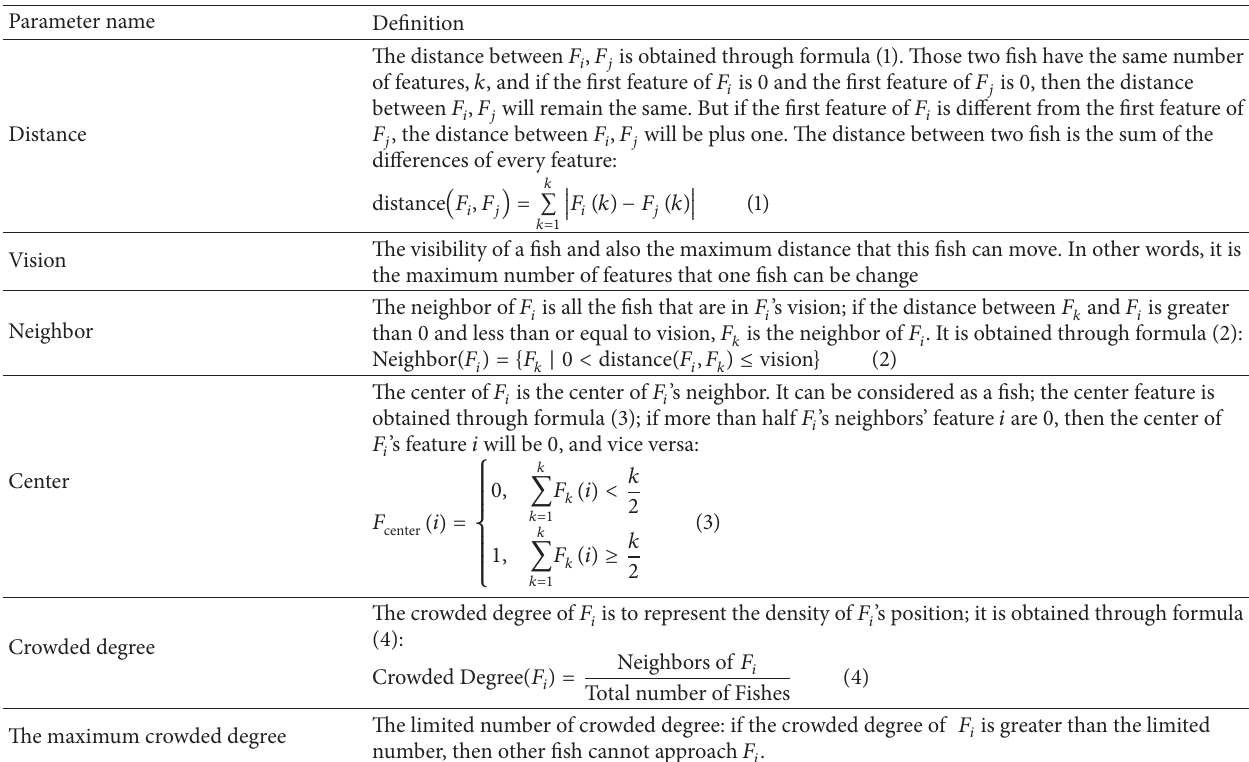
Table 3: Parameters of AFSA.